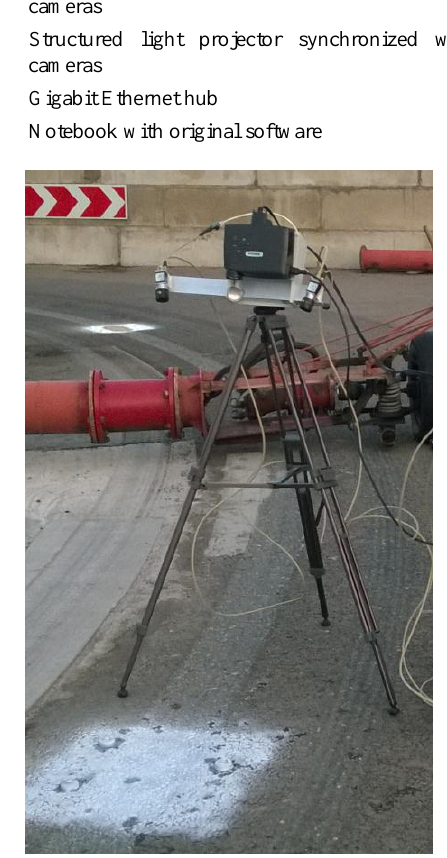
Figure 4. The photogrammetric system at the test